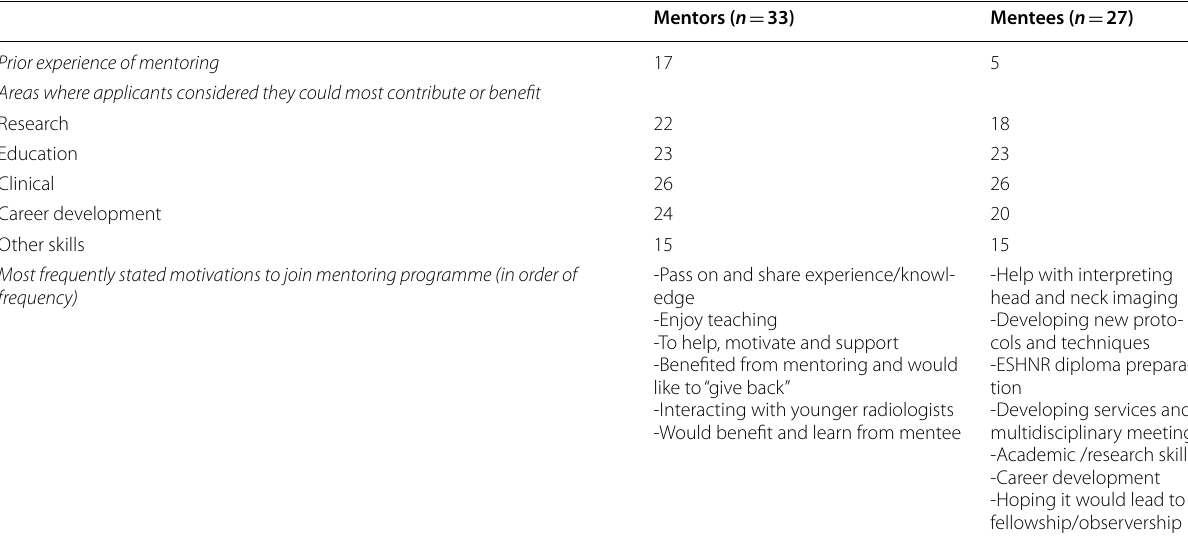
Table 5 Mentoring experience and motivations of the